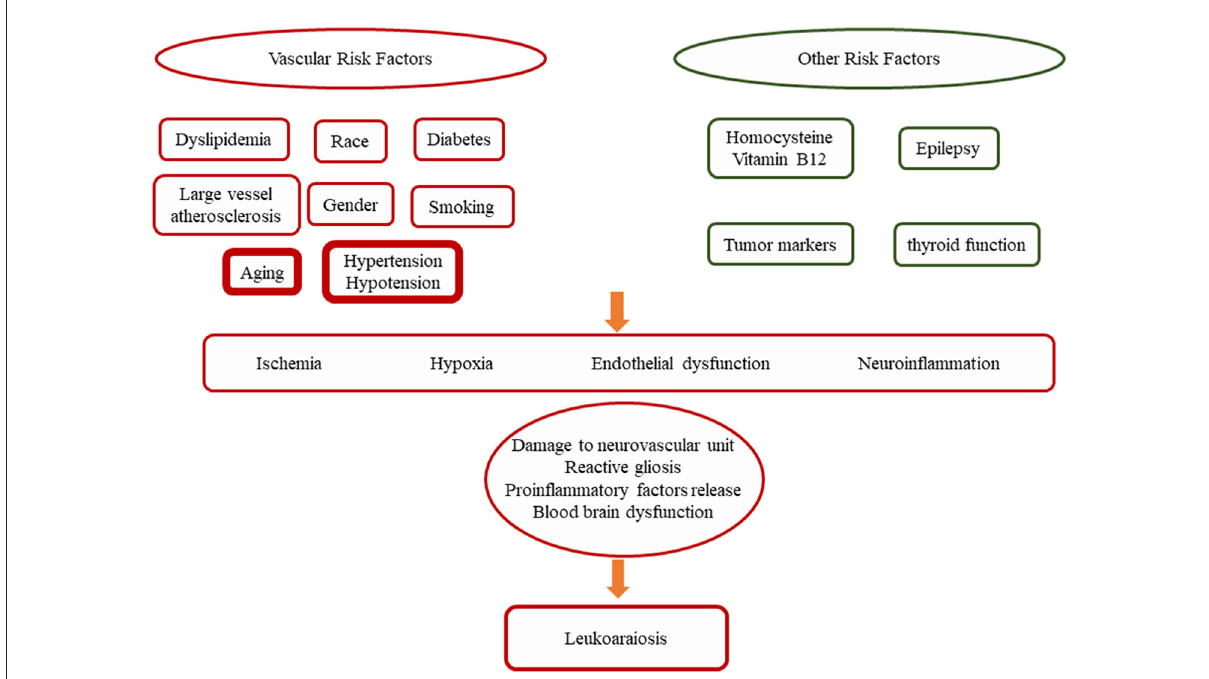
FIGURE2 A synopsis of the possible risk factors conditioning the progression of LA. Among them, age, hypertension and hypotension are considered to be the most important risk factors for LA (Grueter and Schulz, 2012).